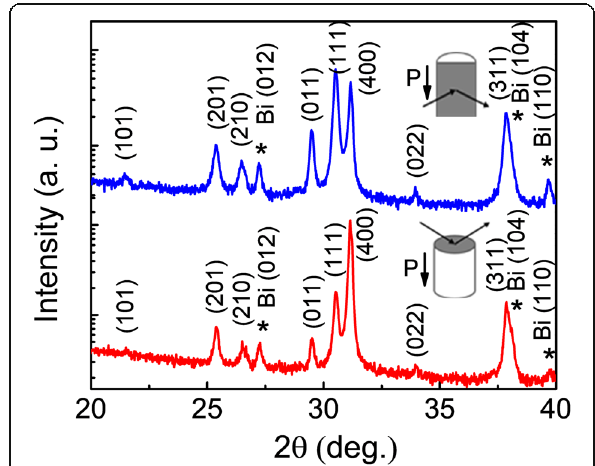
Fig. 1 (Color online) Room temperature XRD patterns for SnSe:Bi 4% perpendicular (red color) and parallel (blue color) to the pressing direction as illustrated in the inset. The figure showed the